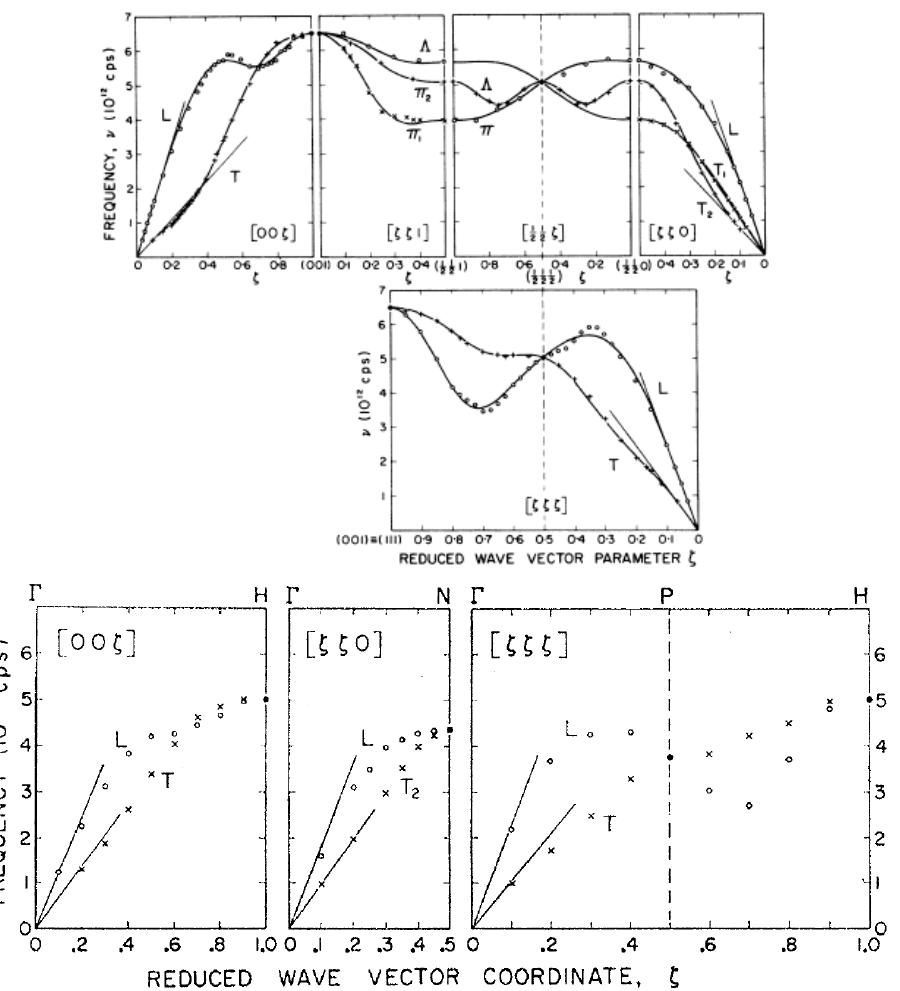
Figure 30. The two upper figures are the phonon dispersion relations in niobium at 296 K for lattice waves traveling in the [00 ζ ], [ ζζ 0], [ ζζζ ], [ ζζ 1], and [½½ ζ ] symmetry directions. The solid curves are the fits to an eighth-neighbor Born–von Kármán force constant model. The lower curves are similar measurements for Ta at 296 K. Lines through q = 0 are calculated from the elastic constants. The upper two figures are taken from Figure 1 of ref. [80] and the lower figure is taken from Figure 1 of ref. [82]. Copyright by the American Physical Society.